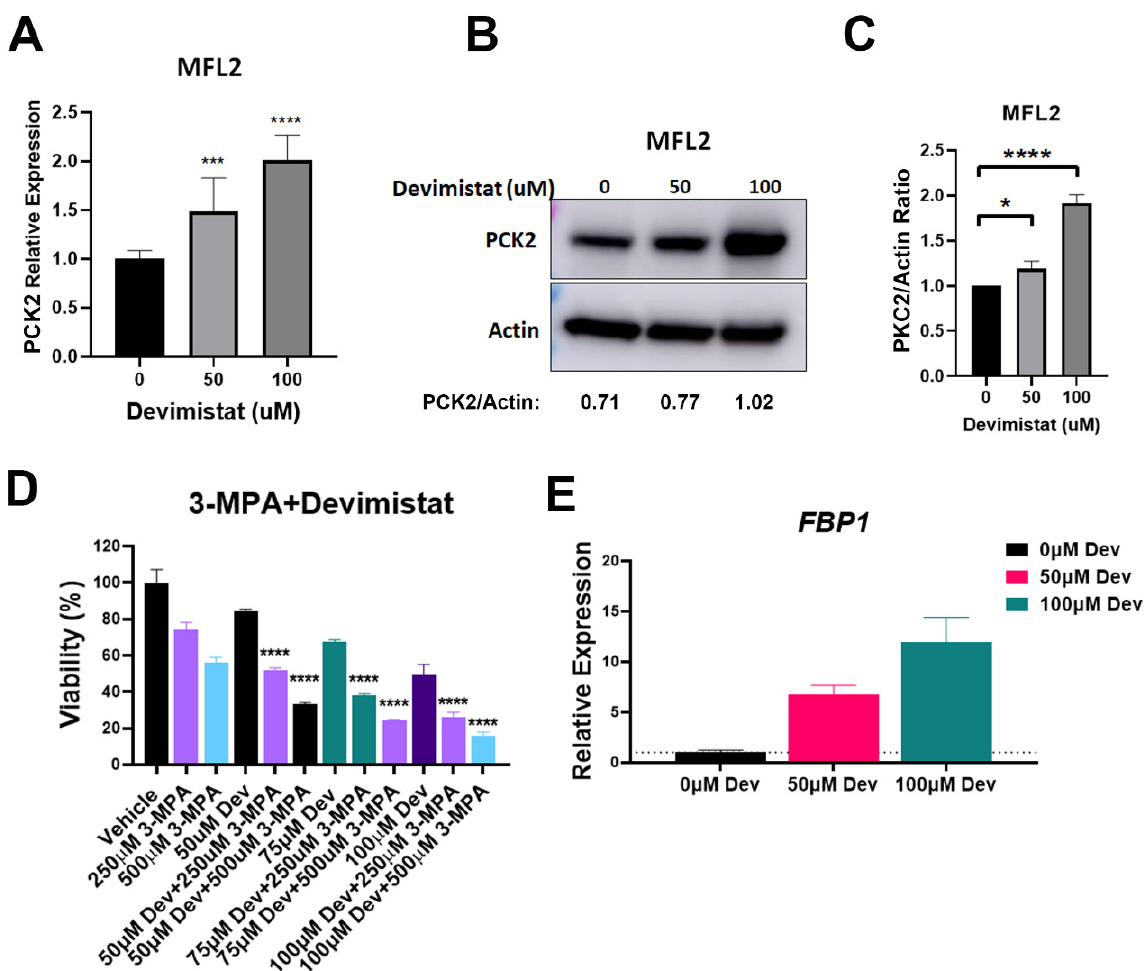
Figure 2. Devimistat induces gluconeogenesis. ( A ) QPCR analysis of PCK2 in MFL2 cells treated with the indicated doses of devimistat for 24 h. ( B ) Western blot analysis of MFL2 cells treated with devimistat at the indicated doses for 24 h. Relative densitometry readings below actin. ( C ) Protein quantification of ( B ) based on actin expression using ImageJ software. ( D ) MFL2 cells were treated as indicated for 72 h and viability assessed. ( E ) MFL2 cells were treated as indicated for 24 h and FBP1 message levels determined by RT-QPCR. **** = p -value less than or equal to 0.0001; *** = p -value less than or equal to 0.001; * = p -value less than or equal to 0.05. Dev = devimistat, 3-MPA = 3- mercaptopicolinic acid. The uncropped blots are shown in File S1.